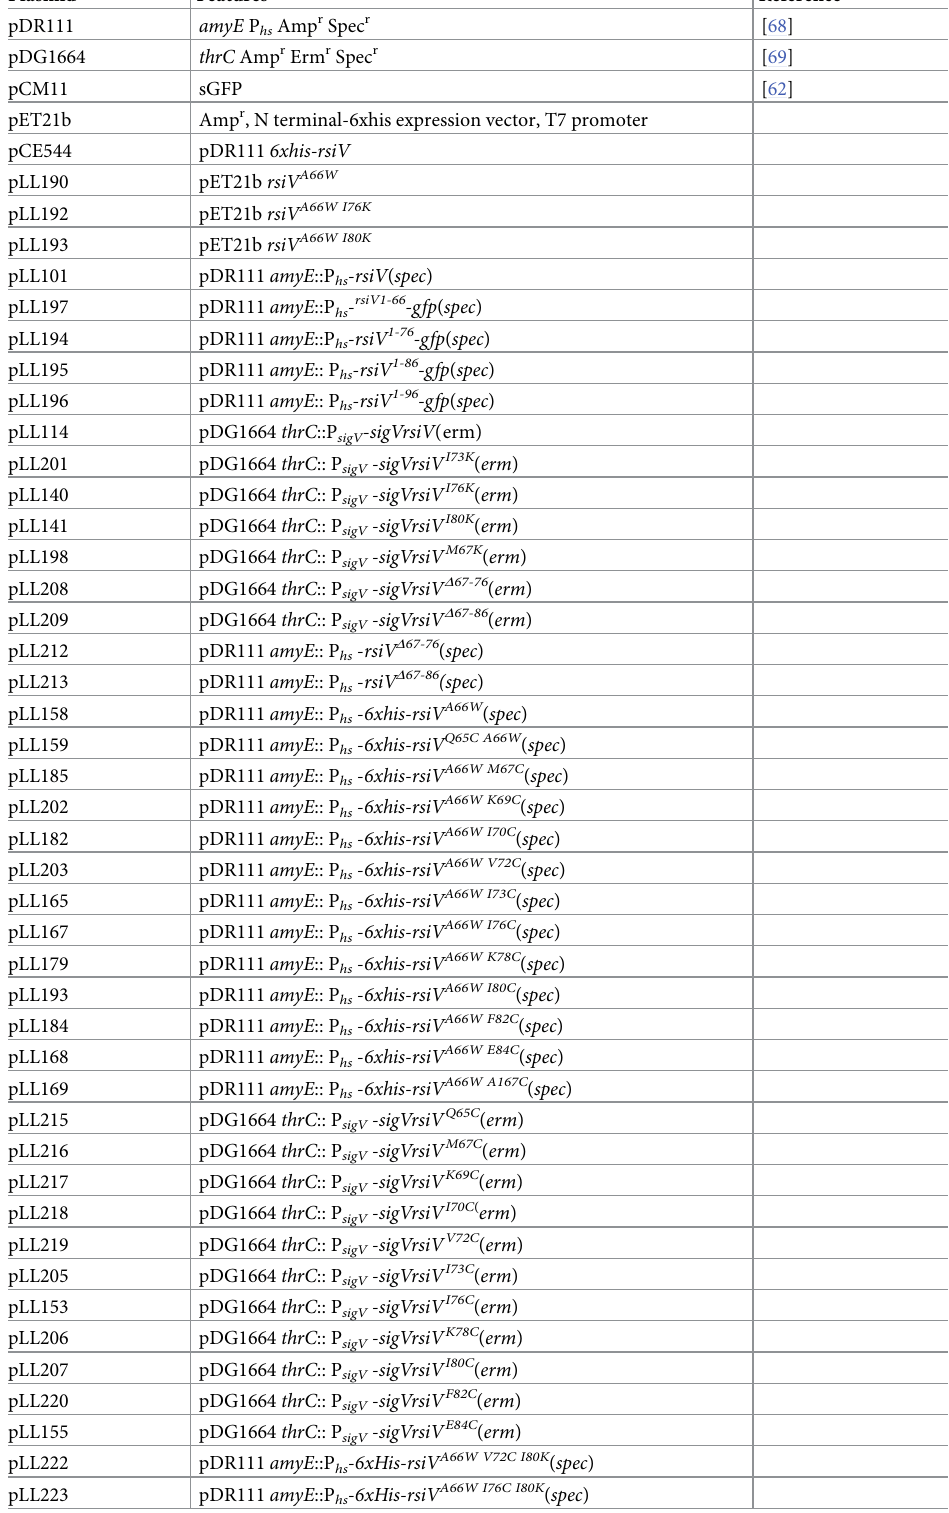
Table 3. Plasmid list.